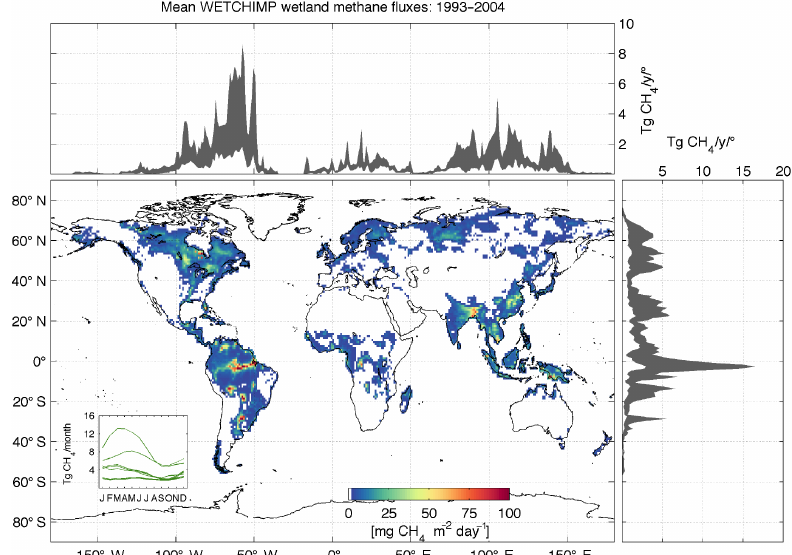
Figure 1. Mean annual wetland and rice CH 4 emissions (central map), and associated longitudinal and latitudinal uncertainty (grey bands), based on the WETCHIMP model inter-comparison project (Melton et al., 2013). Inset: WETCHIMP model total Amazon basin monthly CH 4